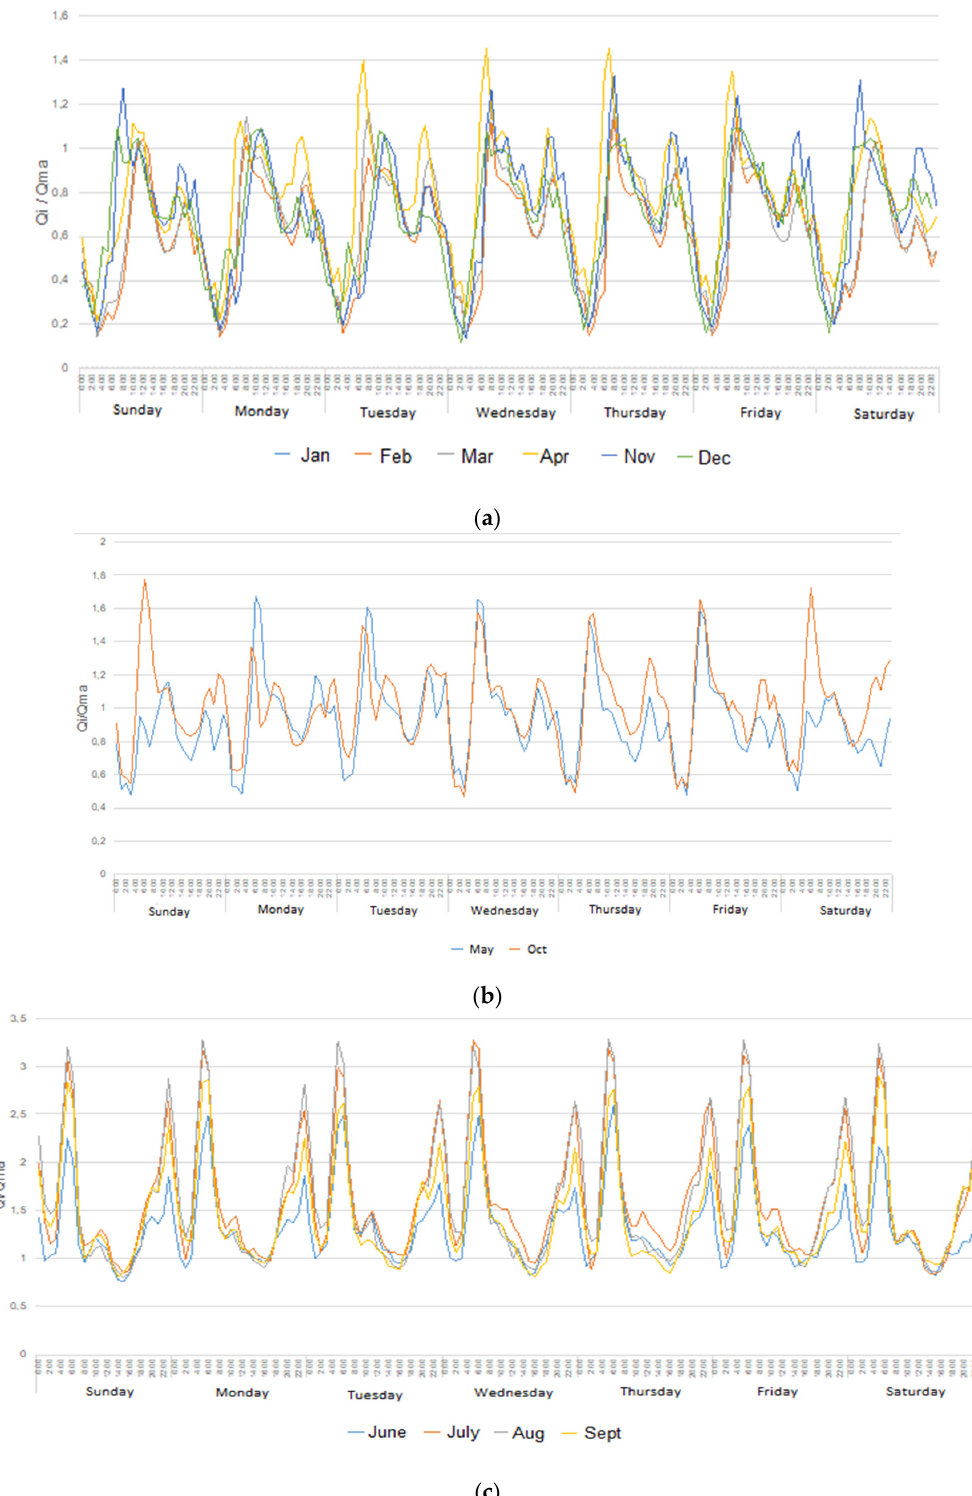
Figure 9. Weekly average hourly demand pattern: ( a ) normal; ( b ) high; ( c ) very high.